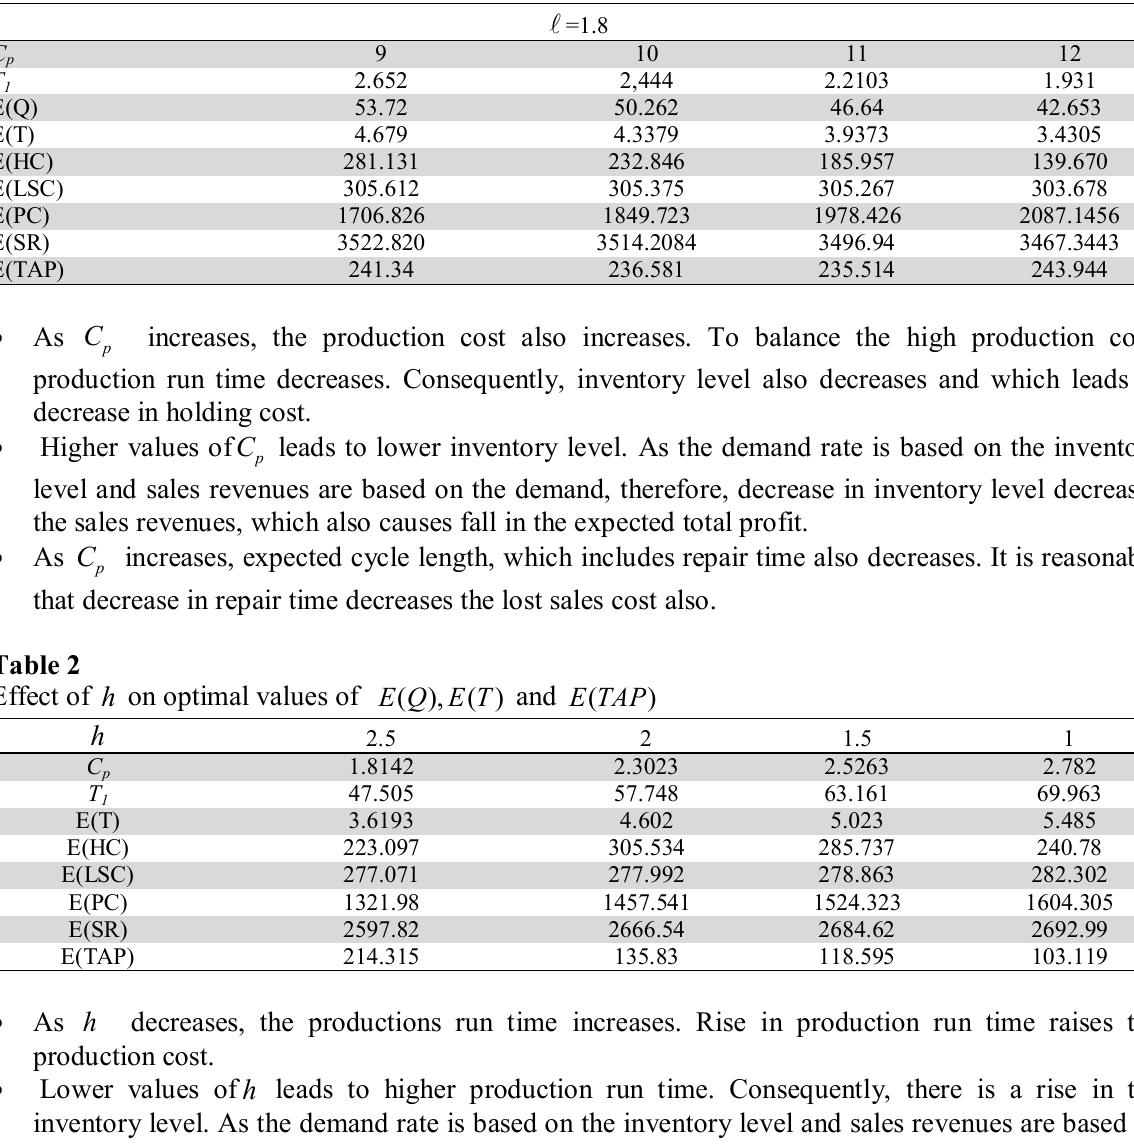
C on optimal values of Effect of p